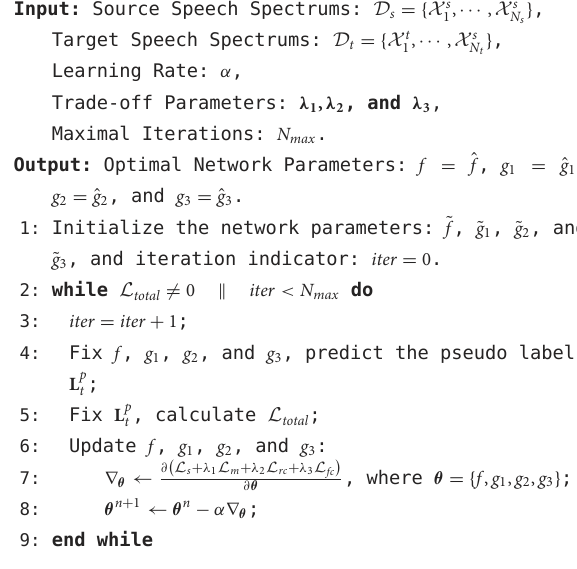
2005), eNTERFACE (Martin et al., 2006), and CASIA